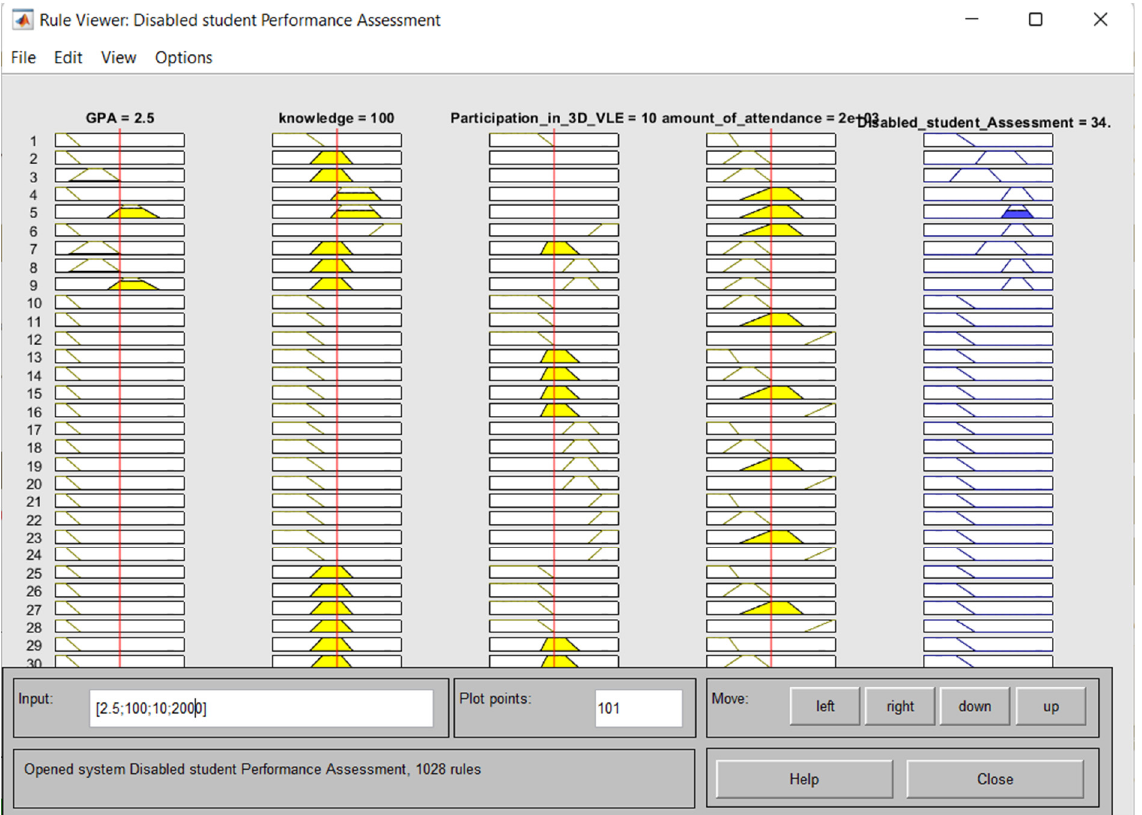
Figure 10. The result of Disabled Student Assessment with MATLAB Toolbox.